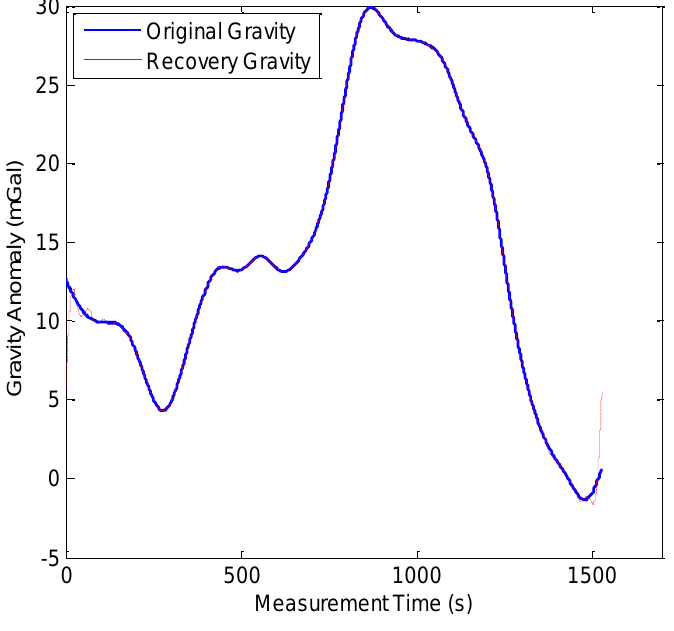
Figure 10. Reconstruction result of OMP in F401.